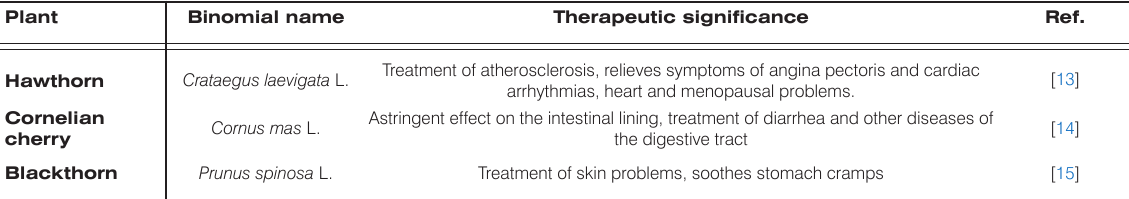
Table 1. Therapeutic uses of plants. Plant